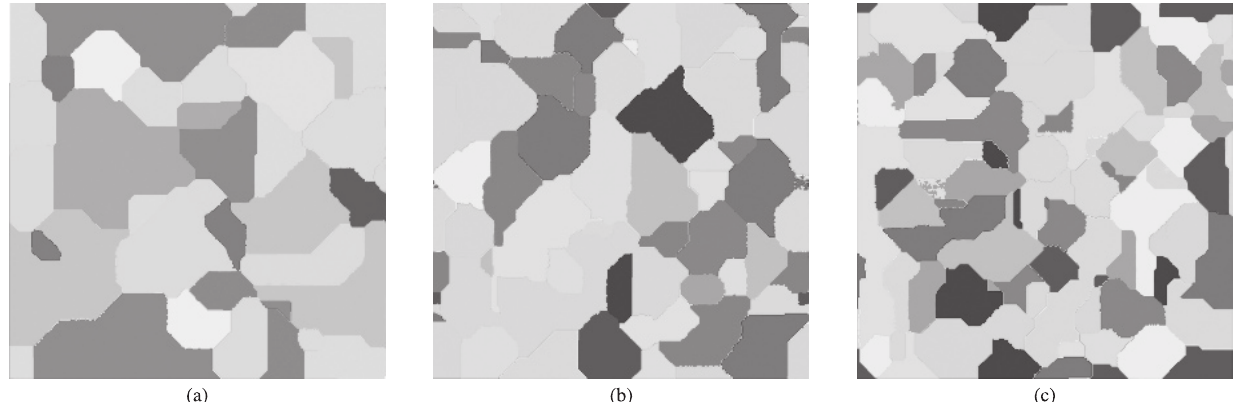
Figure 4. Fully transformed microstructure on cross-sections taken at planes a) x